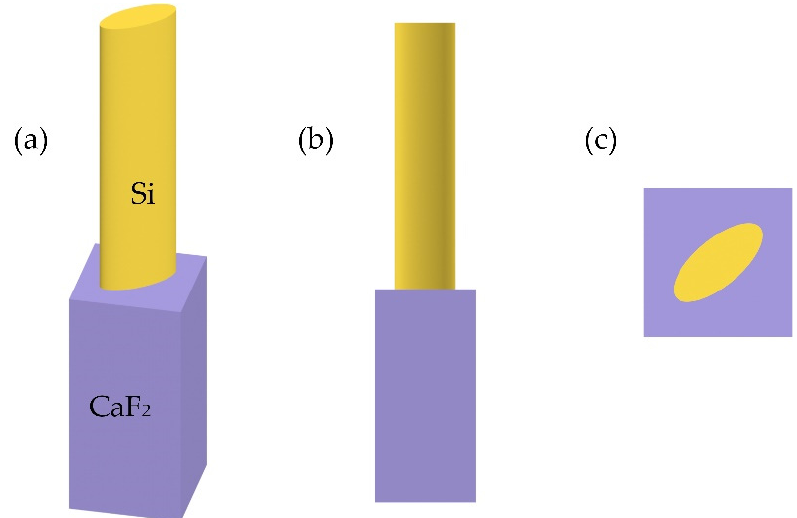
Figure 1. Schematic diagram of the structure of a meta-atom. ( a ) Perspective view. ( b ) Front view. ( c ) Top view.